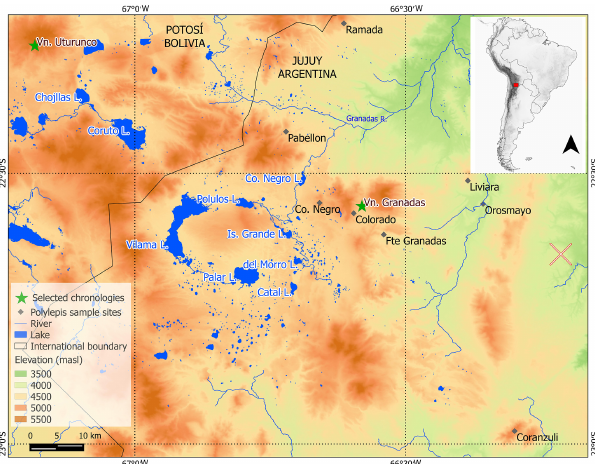
Figure 1. Map showing the Vilama-Coruto lake system in the northwestern Argentina and southwestern Bolivia. Green stars rep- resent the selected tree-ring chronologies used in this